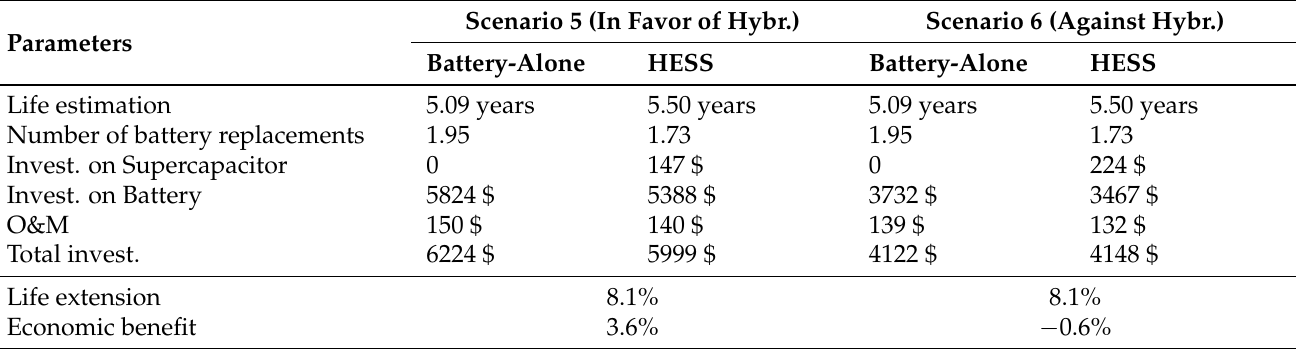
Table 9. Results of different scenarios of economic